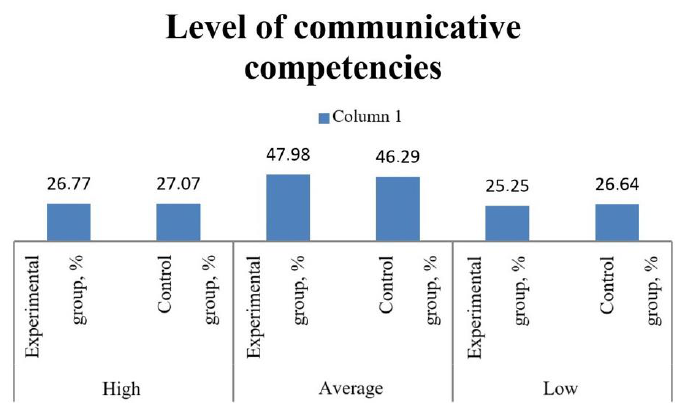
Fig. 3. Dynamics of the distribution of students by the level of communicative competencies Table 9. Expert assessment of the indicators of communicative competencies at the control and experimental stages of the experiment No.